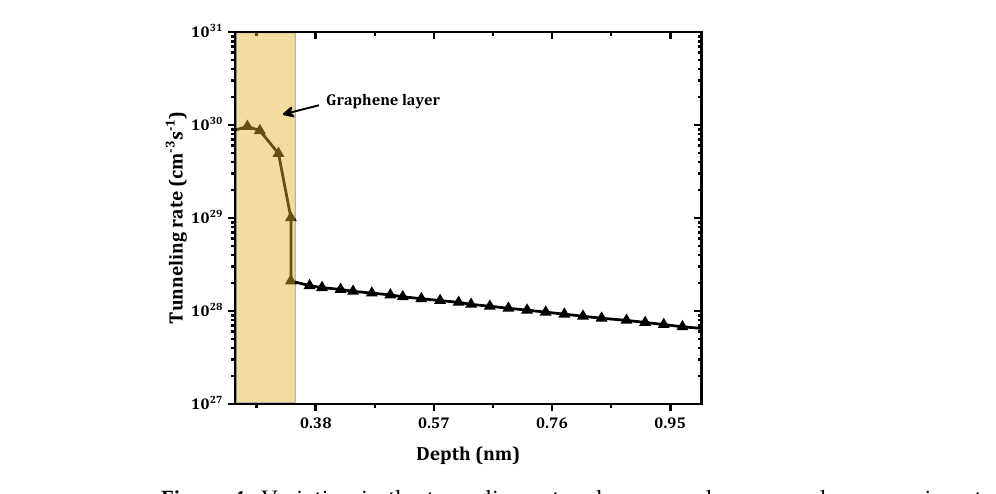
Figure 6. Variation in the output parameters of the proposed SBD versus the graphene bandgap. This decrease in the tunneling rate led to a decrease in the saturation current as pre- sented in Figures 5 and 6.